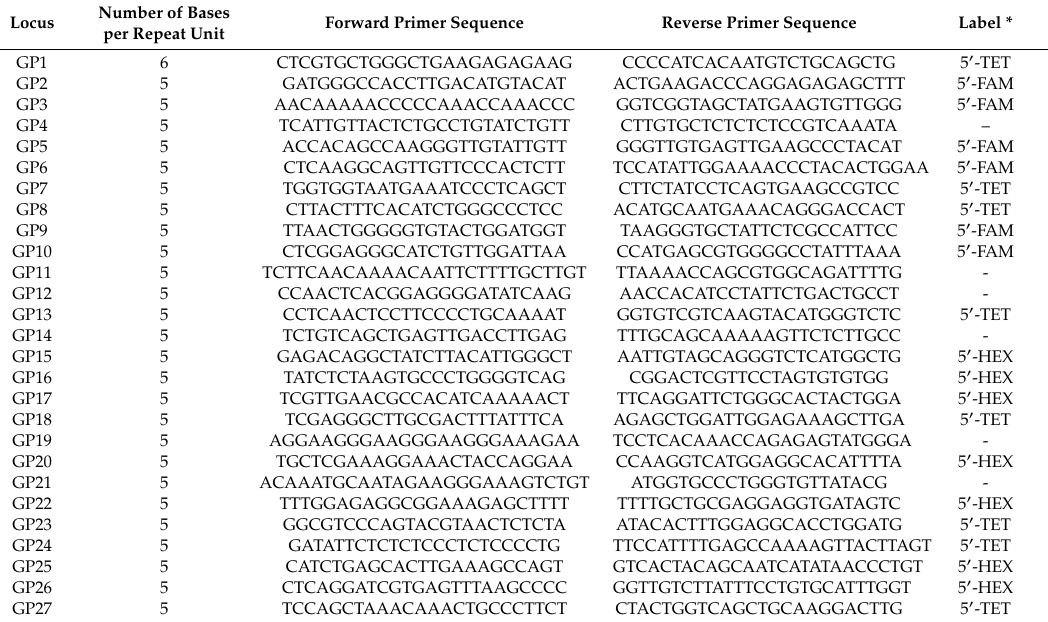
Table 2. The primers of the giant panda